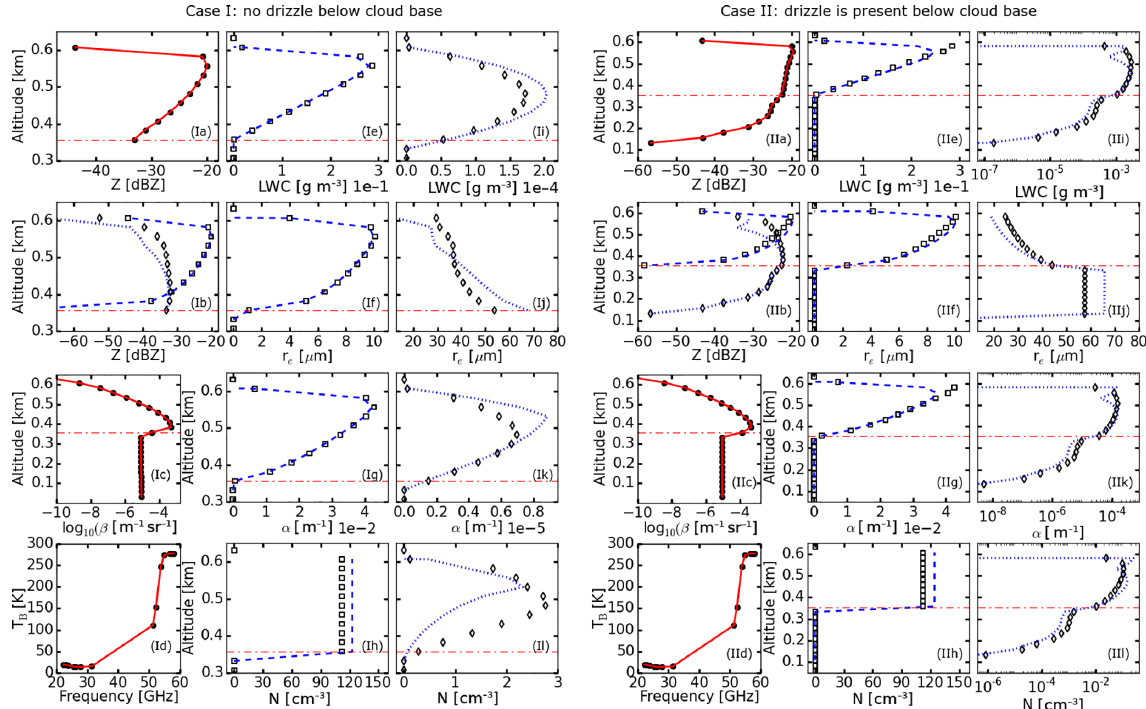
Figure 6. Examples of cloud and drizzle profiling for the two drizzle cases described in Sect. 2.2.2. Panels (Ia) – (Il) show the results for case I and panels (IIa) – (IIl) for case II. The red dashed–dotted lines mark the cloud base height z cb , opt . Filled circles: synthetic signals; squares: the cloud truth; diamonds: drizzle truth; red solid lines: retrieved signals; blue dashed lines: retrieved cloud properties; blue dotted lines: retrieved drizzle